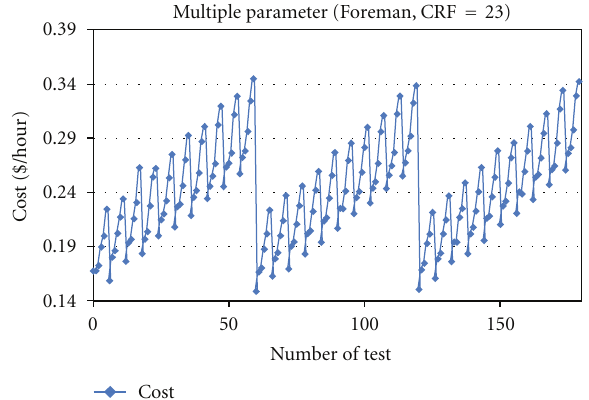
Figure 19: Encoding cost under combinations of four parameters (Foreman, crf = 23).